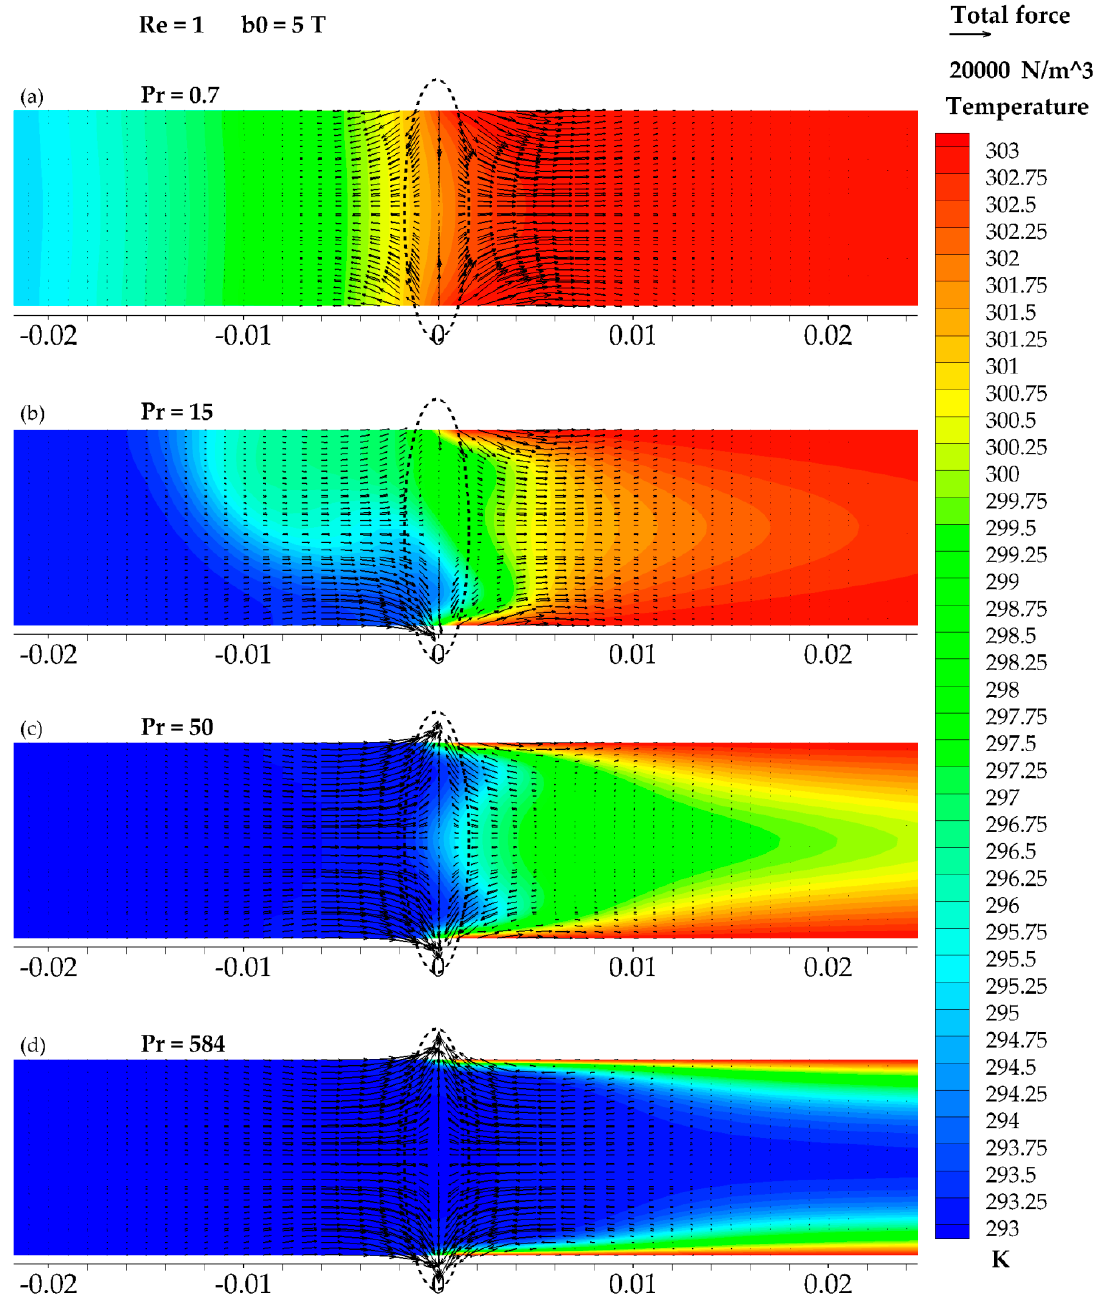
Figure 8. Temperature and total force distribution in the axial cross-section at Re = 1 and b 0 = 5 T: ( a ) Pr = 0.7, ( b ) Pr = 15, ( c ) Pr = 50, ( d ) Pr = 584.